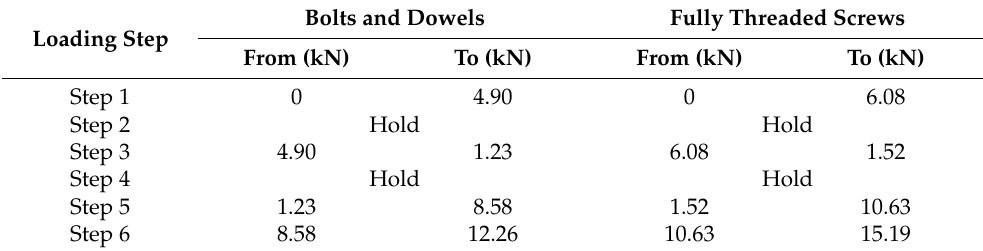
Table 1. The course of the experimental testing Johanides 2022